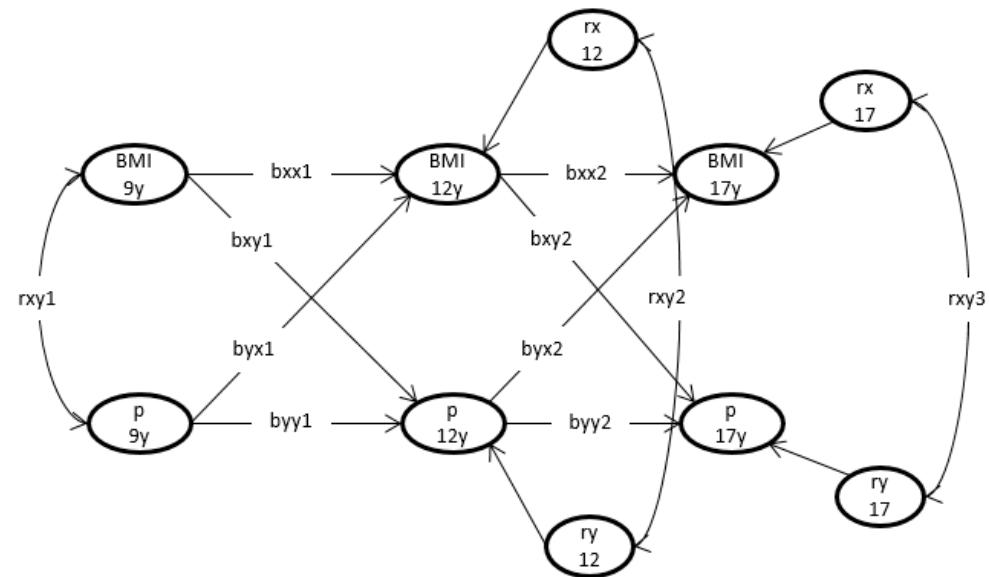
Figure 1. Representation of the model to explore the temporal relation between BMI and cortisol indices. The arrows represent the causal pathways, and the double-headed arrows represent the correlations. BMI = body mass index, assessed at ages 9, 12, and 17 years. P represents the cortisol parameters at those ages. This model includes autoregressions, cross-lagged regressions, and synchronous correlations. The parameters bxx1 and bxx2 are the autoregressive coefficients of BMI, which link the successive BMI values. The parameters byy1 and byy2 are the autoregressive coefficients of the cortisol indices, which link the successive cortisol indices. The parameters bxy1 and bxy2 are the cross-lagged regression coefficients in the regression of the cortisol index on BMI, and byx1 and byx2 are the cross-lagged regression coefficients in the regression of BMI on the cortisol index. Finally, rxy1, rxy2, and rxy3 are the synchronous correlations between BMI and the cortisol index at age 9 (rxy1), and between the residuals of BMI and the cortisol indices at ages 12 and 17 (rxy2 and rxy3, respectively).